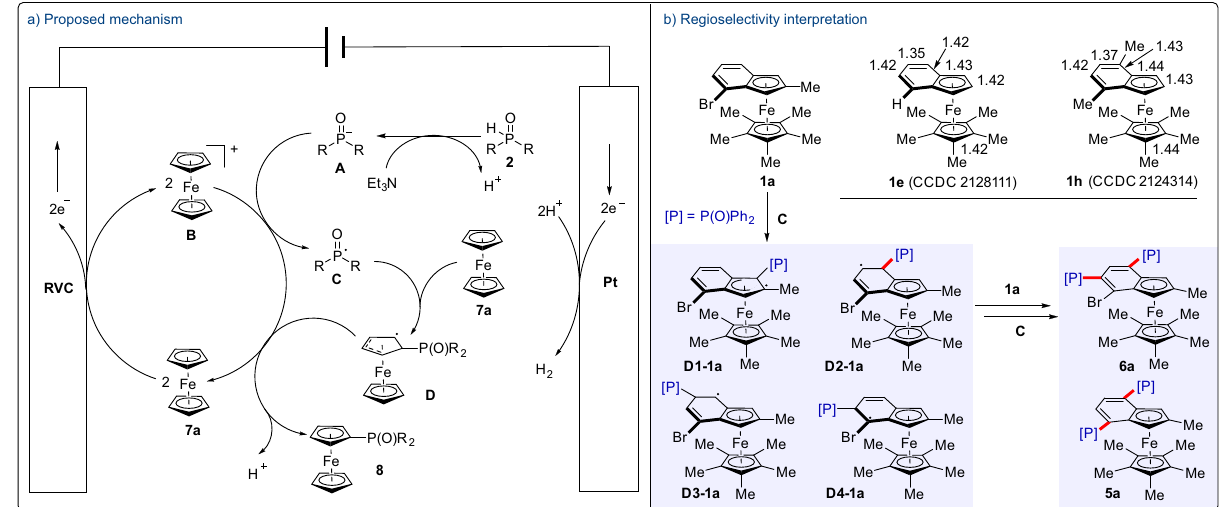
Fig. 5 Proposed mechanism. a Proposed mechanism. b